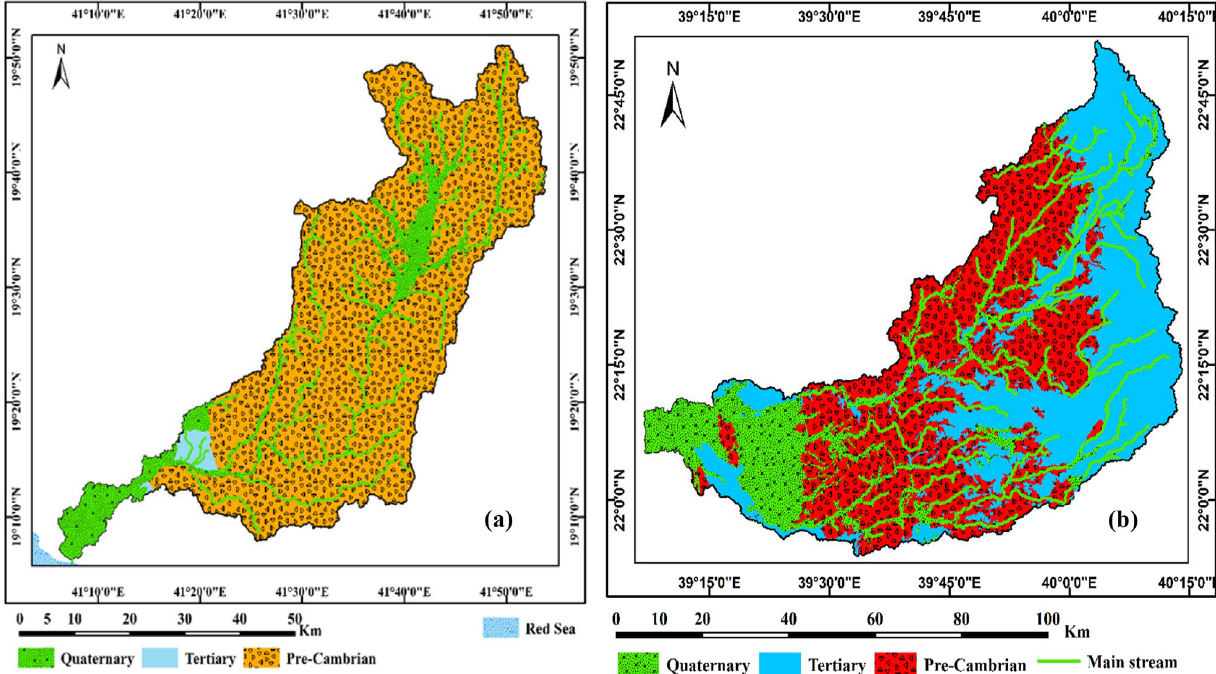
Fig. 4 Geologic maps: a Wadi Qanunah basin, and b Wadi Marawani basin, Makkah Al-Mukarramah Province, Saudi